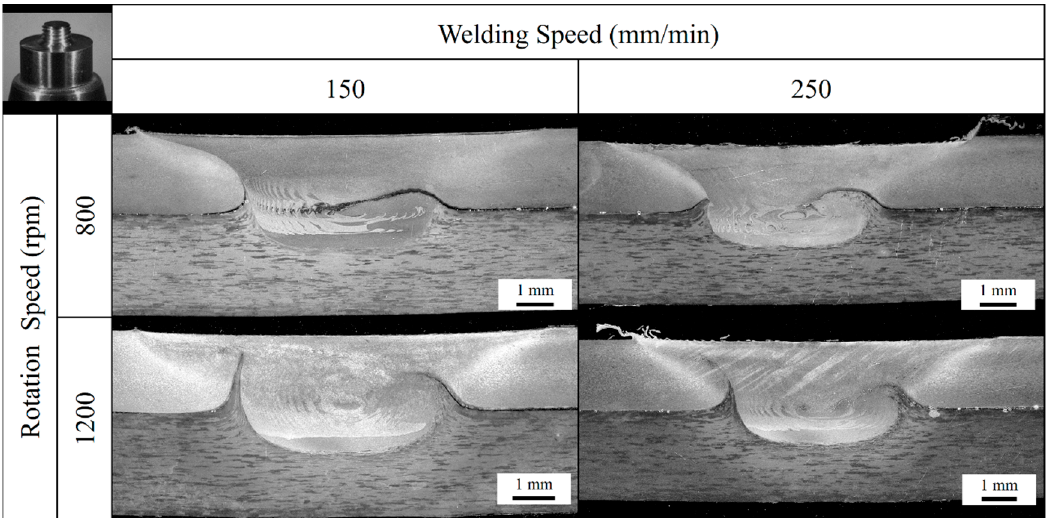
Figure 5. Transverse macro-sections of the friction stir welding (FSW) lap joints performed with the conventional threaded tool. The advancing side is located at the left of the image for all macro-sections. Tool translation movement was forward from the shown cross-section.